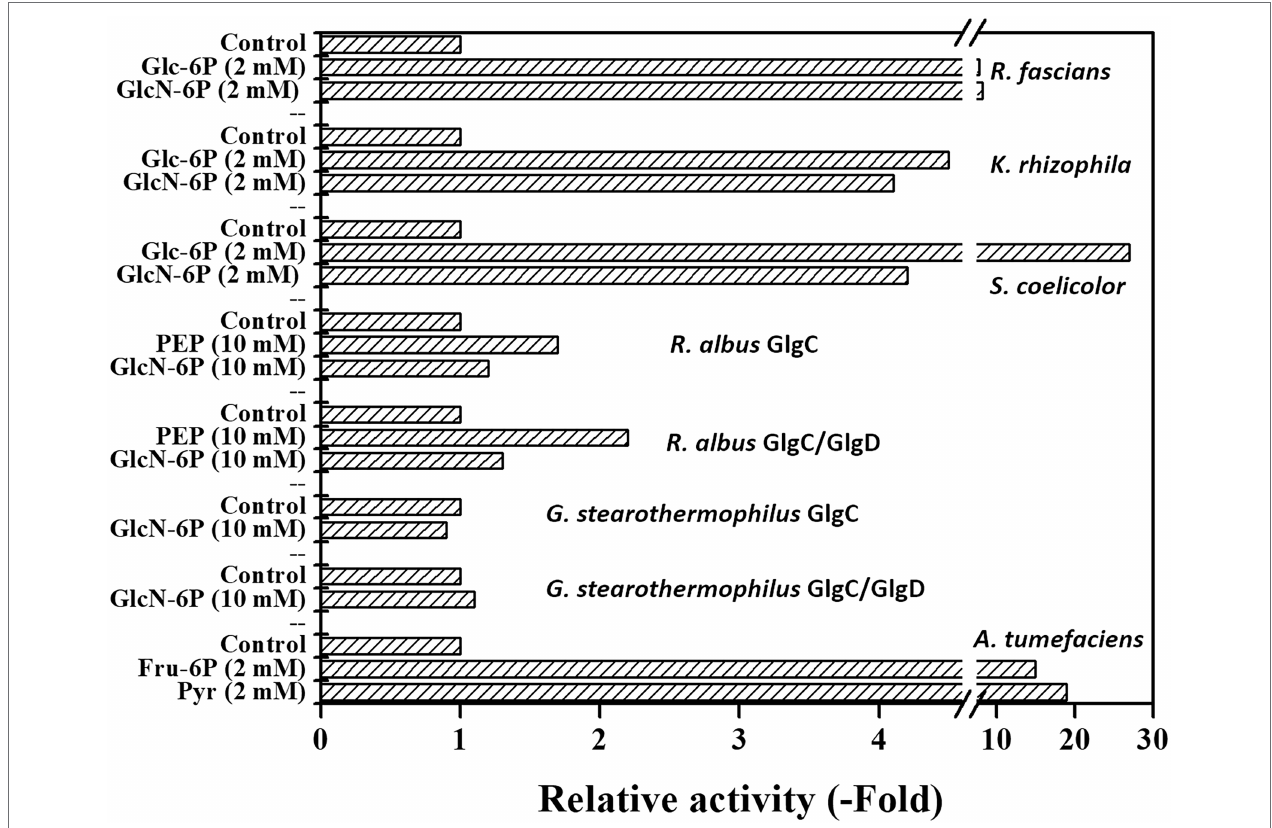
FIGURE 1 | GlcN-6P as effector of bacterial ADP-glucose pyrophosphorylases (ADP-Glc PPases). Activities were measured according to the section “Materials and Methods,” using indicated effector